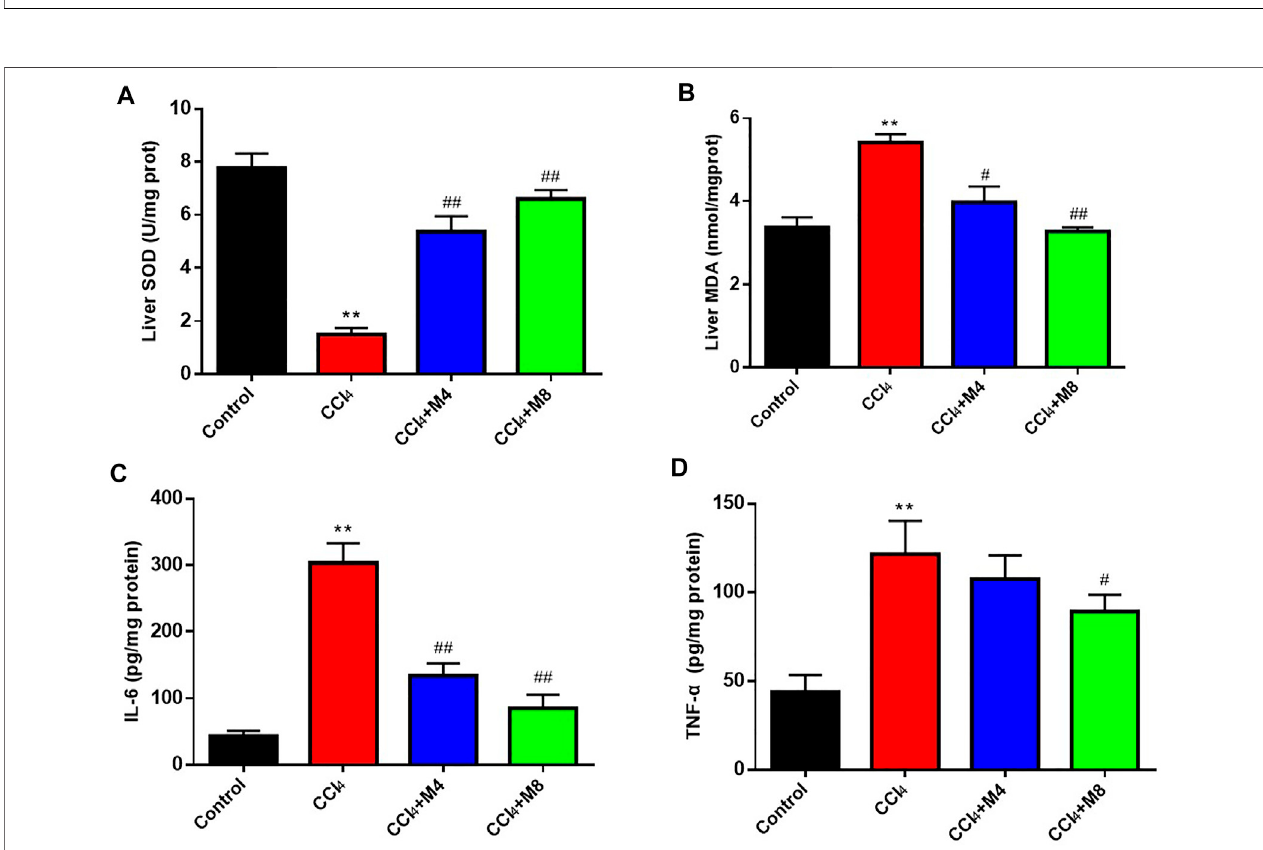
FIGURE7| Theeffectsofmidazolam onthelevelsofSOD (A) ,MDA (B) ,IL-6 (C) and TNF- α (D) inmice liver.( n =8ineach group). ** p < 0.01 vs. thecontrolgroup; # p < 0.05 and ## p < 0.01 vs. CCl 4 group.